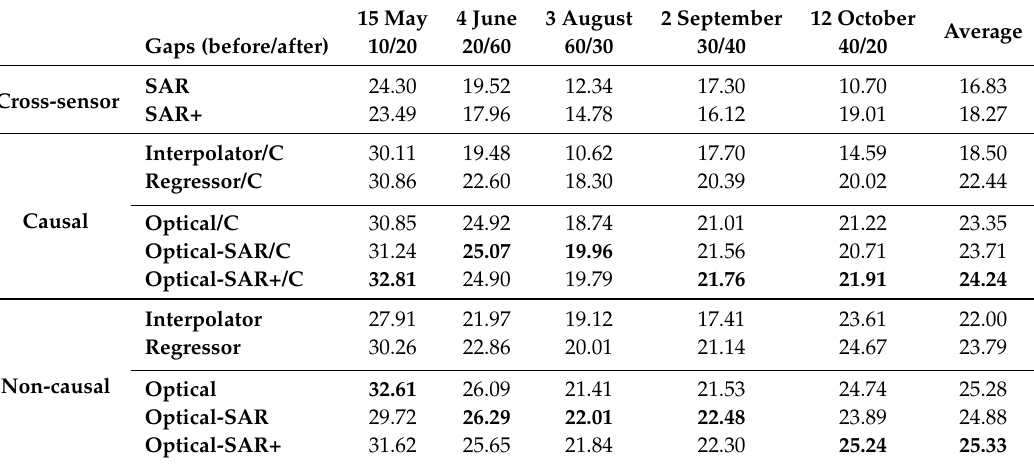
Table 5. Peak signal-to-noise ratio (PSNR) (dB).